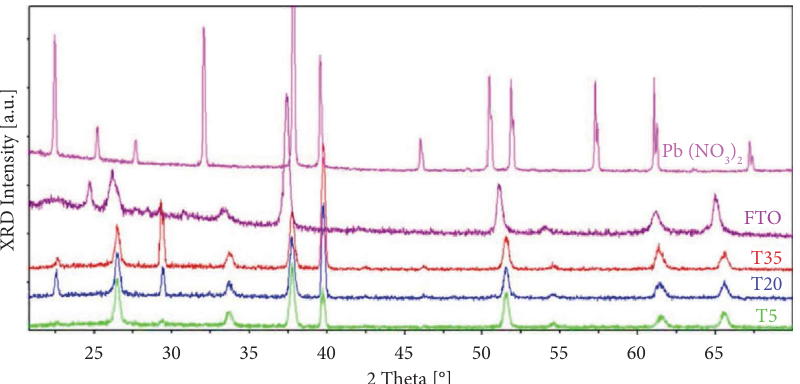
Figure 7: Te XRD pattern of the lead deposited on an FTO substrate (with a potential pulse at − 0.8V at diferent temperatures). Te patterns of Pb(NO 3 ) 2 and FTO are given for